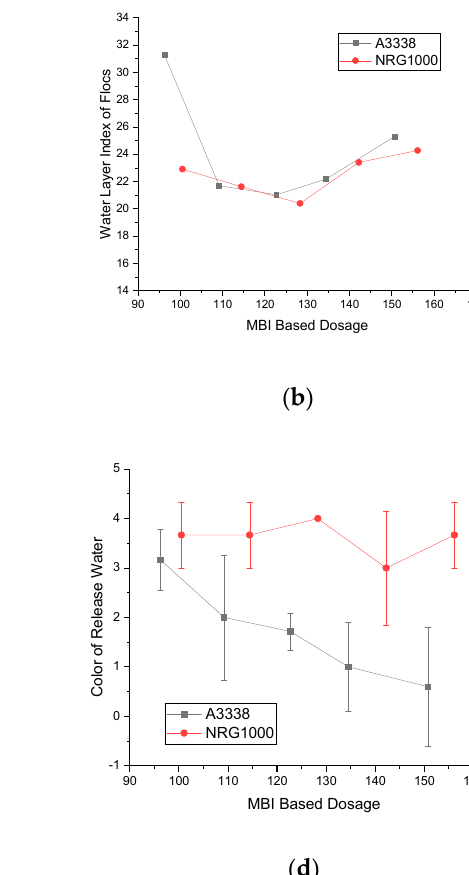
( b ) Figure 13. Flocculated FFT-1 by polymer NRG1000 at the same polymer dosage: ( a ) polymer solution injection rate at 84 mL/s; ( b ) polymer solution injection rate at 33 mL/s. 3.7. Example of Polymer Evaluation on FFT Treatment A robust flocculation method is the key to evaluate various flocculants for tailings treatment. The improved testing repeatability and reproducibility by the torque-oriented mixing allows the polymer evaluation and screening to be more credible, and improves the ability to confidently discern performance differences between different polymers. Figure 14 shows the comparison of dewatering performance of polymer A3338 and poly-